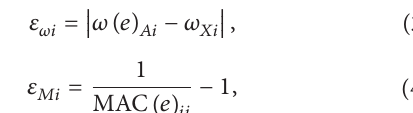
Figure 4: Modal test devices.